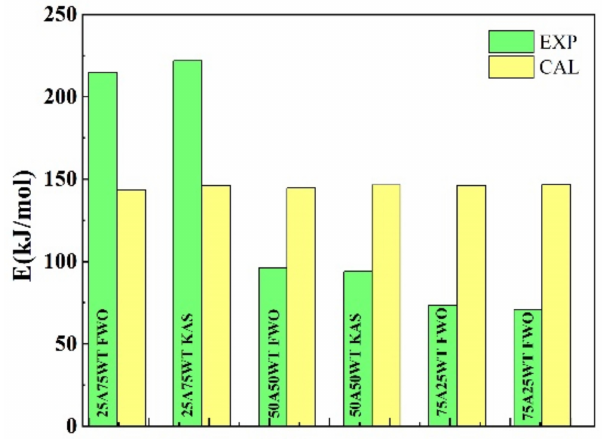
Figure 7. A comparison of the experimental and the calculated activation energy for the blends without HZSM-5.